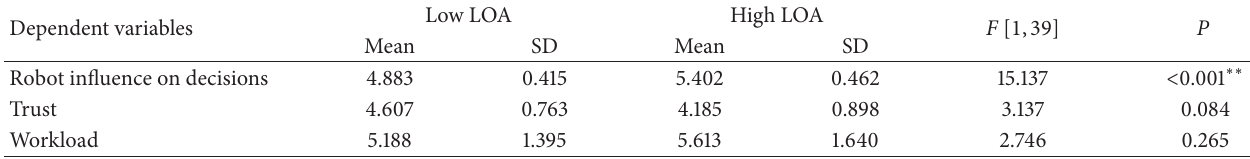
Table 5: Univariate effects for level of robot autonomy.